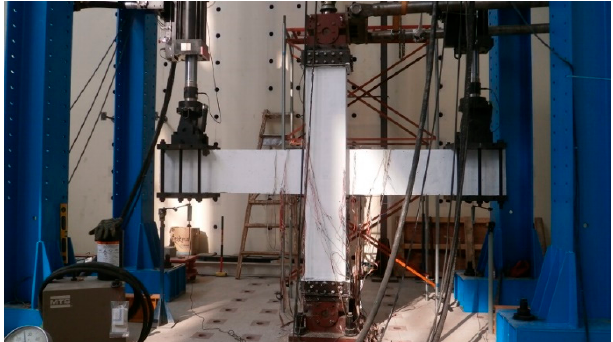
Figure 5. Test set-up of the joints.